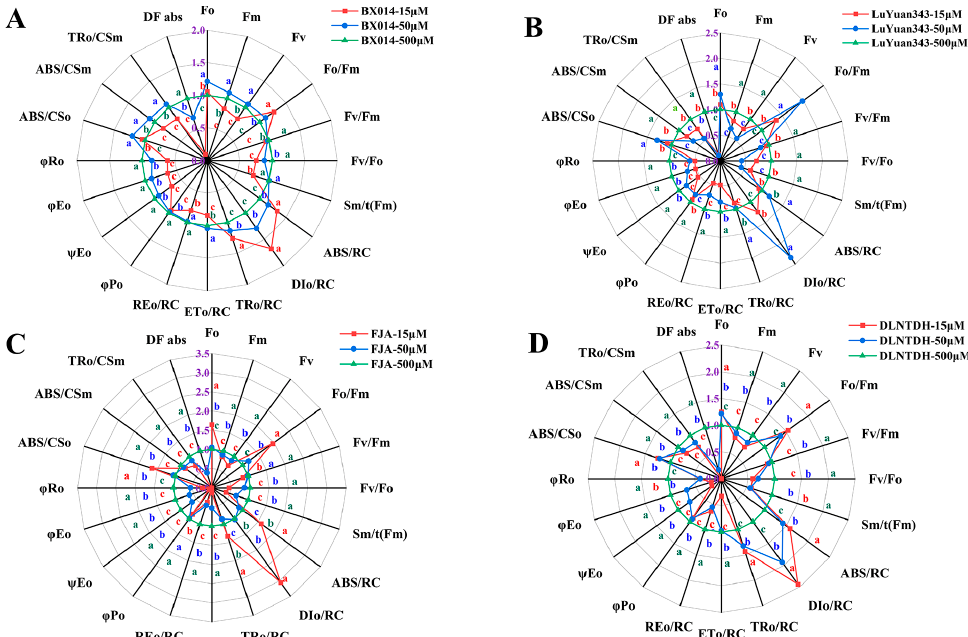
Figure 7. Spider plot of Chl a fluorescence of cotton leaves, the value of 500µM P set 1. ( A ) BX014, ( B ) LuYuan343, ( C ) FJA, ( D ) DLNTDH, at different P treatments. The results are expressed as means ± SE ( n = 7). Statistically significant changes are indicated by different letters, using the one-way ANOVA and multiple-comparison test ( p ≤ 0.05). and multiple-comparison test ( p ≤